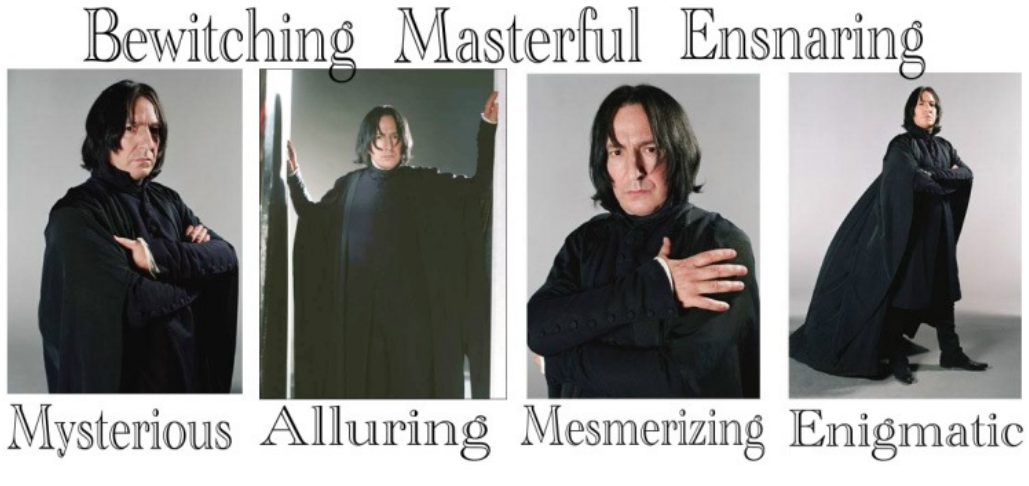
Figure 5. The virtues of Snape, as explored by Rose